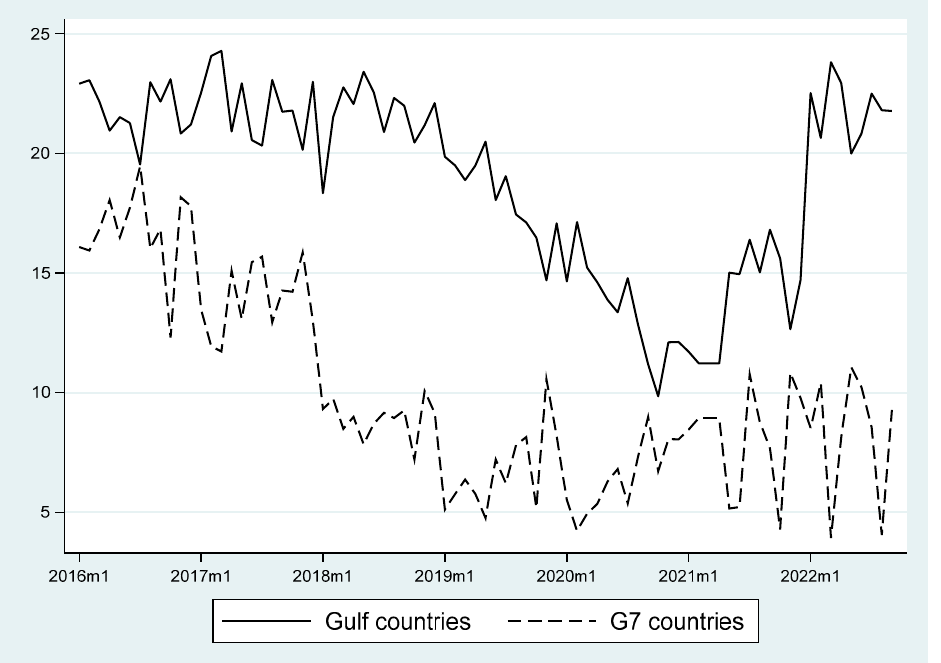
Figure 2. Percentage share of the total deposits. Note: This fi gure shows the percentage share of the total deposits in the selected bank. The GCC countries and G7 counties represent remi tt ance receipts from GCC and G7 nations, respectively. The remaining shares are received from other sources, in- cluding salaries and regular